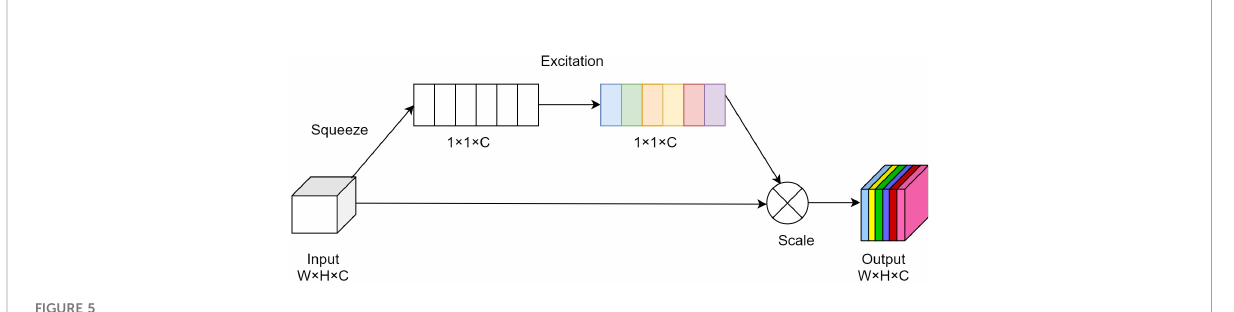
FIGURE 5 Structure diagram of attention mechanism.